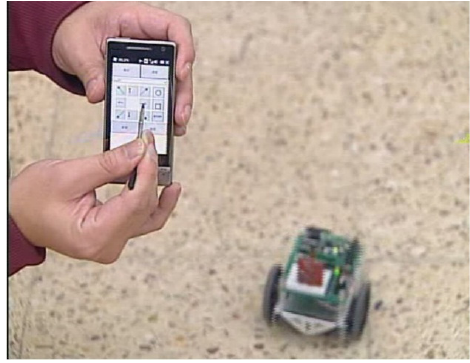
Figure 20. Smartphone control example: Right ‐ turn operation; press right arrow. Appl. Sci. 2016, 6, 82